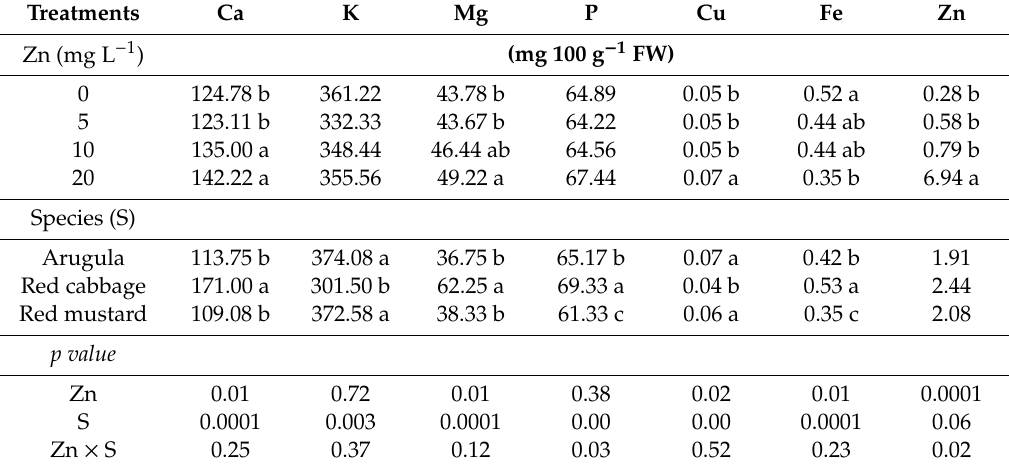
Table 2. Nutrient solution zinc (Zn) level e ff ects on the concentration (mg 100 g − 1 FW) of calcium (Ca), potassium (K), magnesium (Mg), phosphorous (P), copper (Cu), iron (Fe), and Zn in arugula, red cabbage, and red mustard microgreens 1